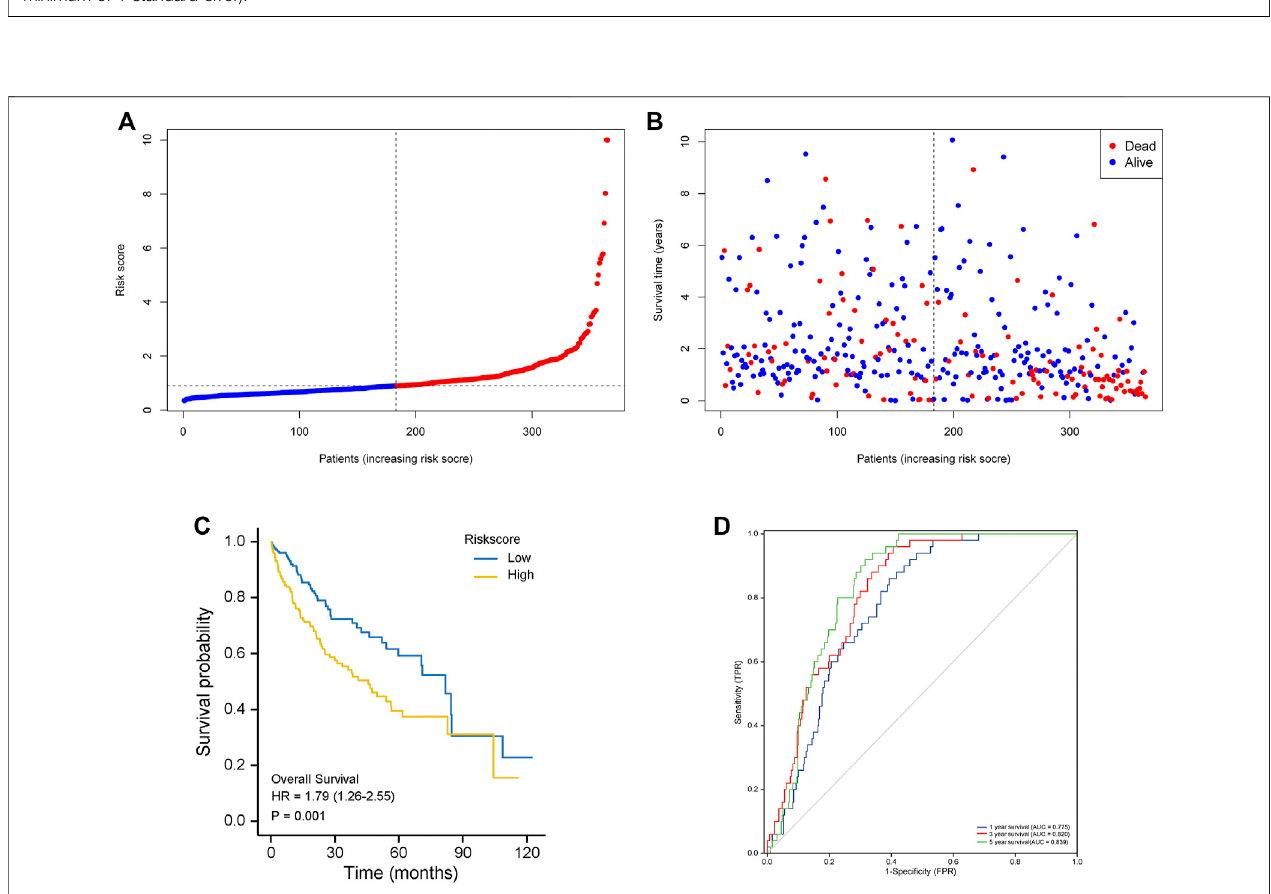
FIGURE 3 | The seven m7G-related genes signature model ’ s prognostic value in the test (TCGA) cohort. (A) The risk score distribution and median values. (B) overall survival status, overall survival, and risk score distributions in the derivation cohort. (C) Kaplan – Meier curves show the overall survival of patients in the high-risk and low-risk groups. (D) The area under the curves of time-dependent ROC curves shows the risk score ’ s prognostic performance.